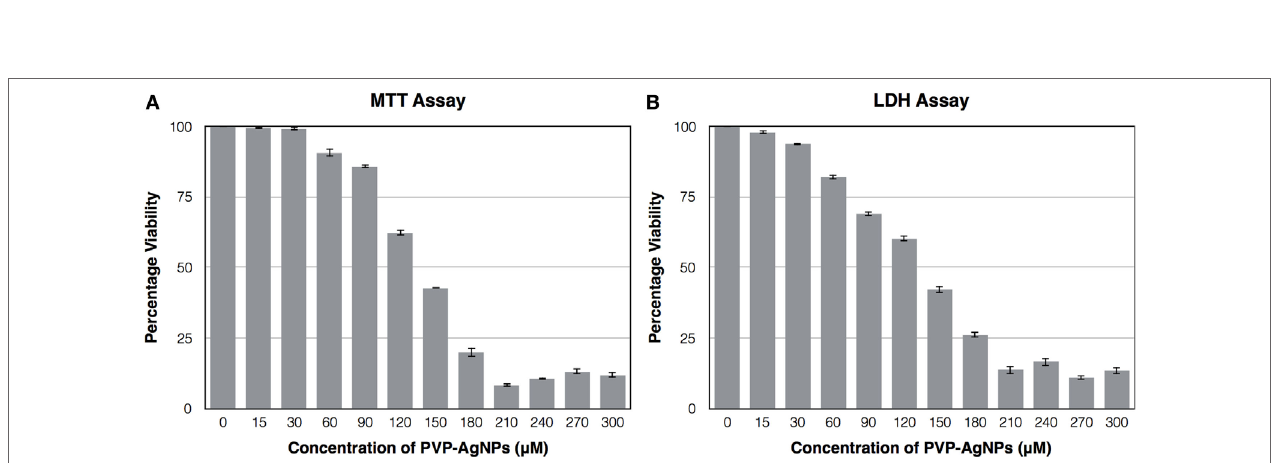
FigUre 3 | Characterization of PVP-capped AgNPs using UV-Vis spectroscopy (a) and dynamic light scattering (B) . Similarly section (c) showed comparative growth curve of RS-307 strain of Acinetobacter baumannii in the absence and presence of PVP-capped silver nanoparticles. Growth curve experiments were performed in triplicate and data are presented as mean ± SD.